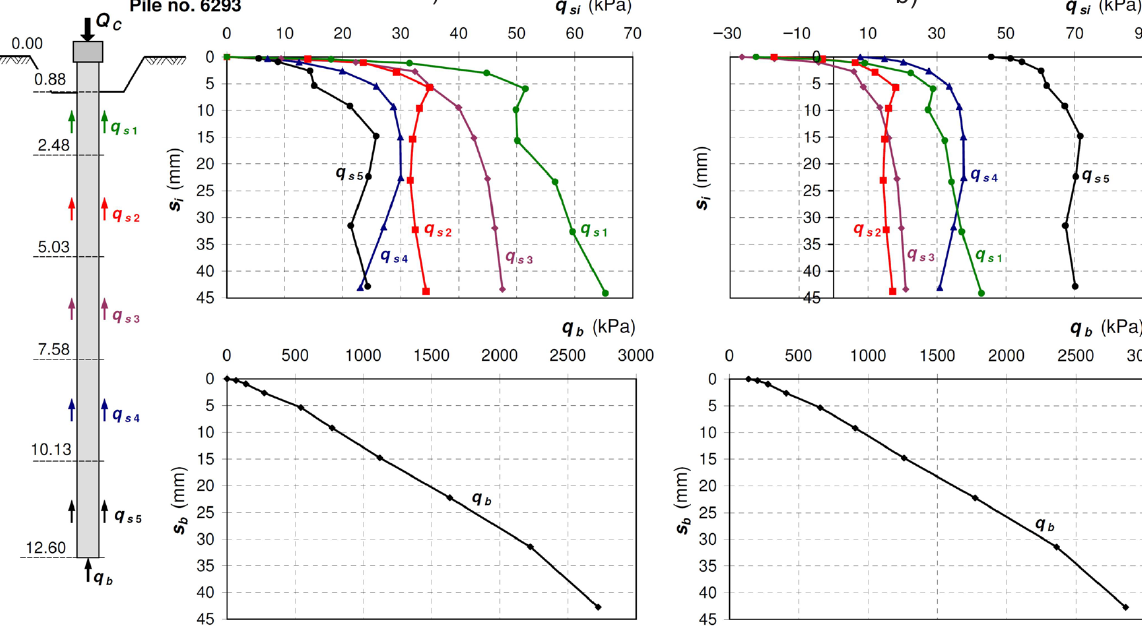
Figure 10: Pile no. 6293, comparison of q residual force and b) taking into account the residual